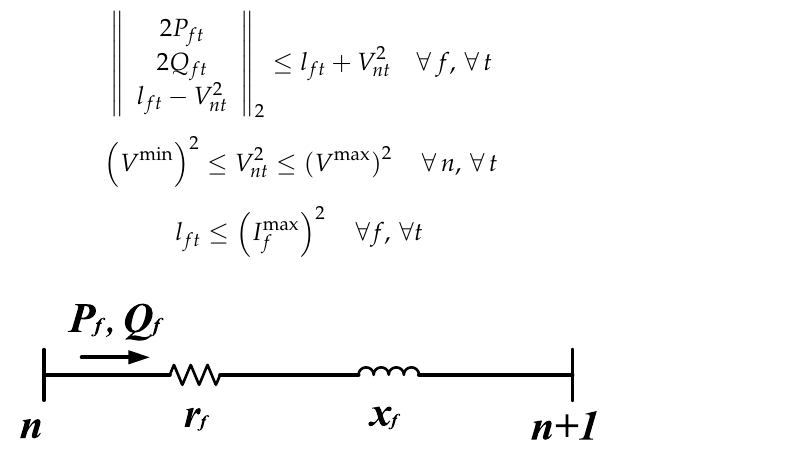
Figure 2. Model of distribution